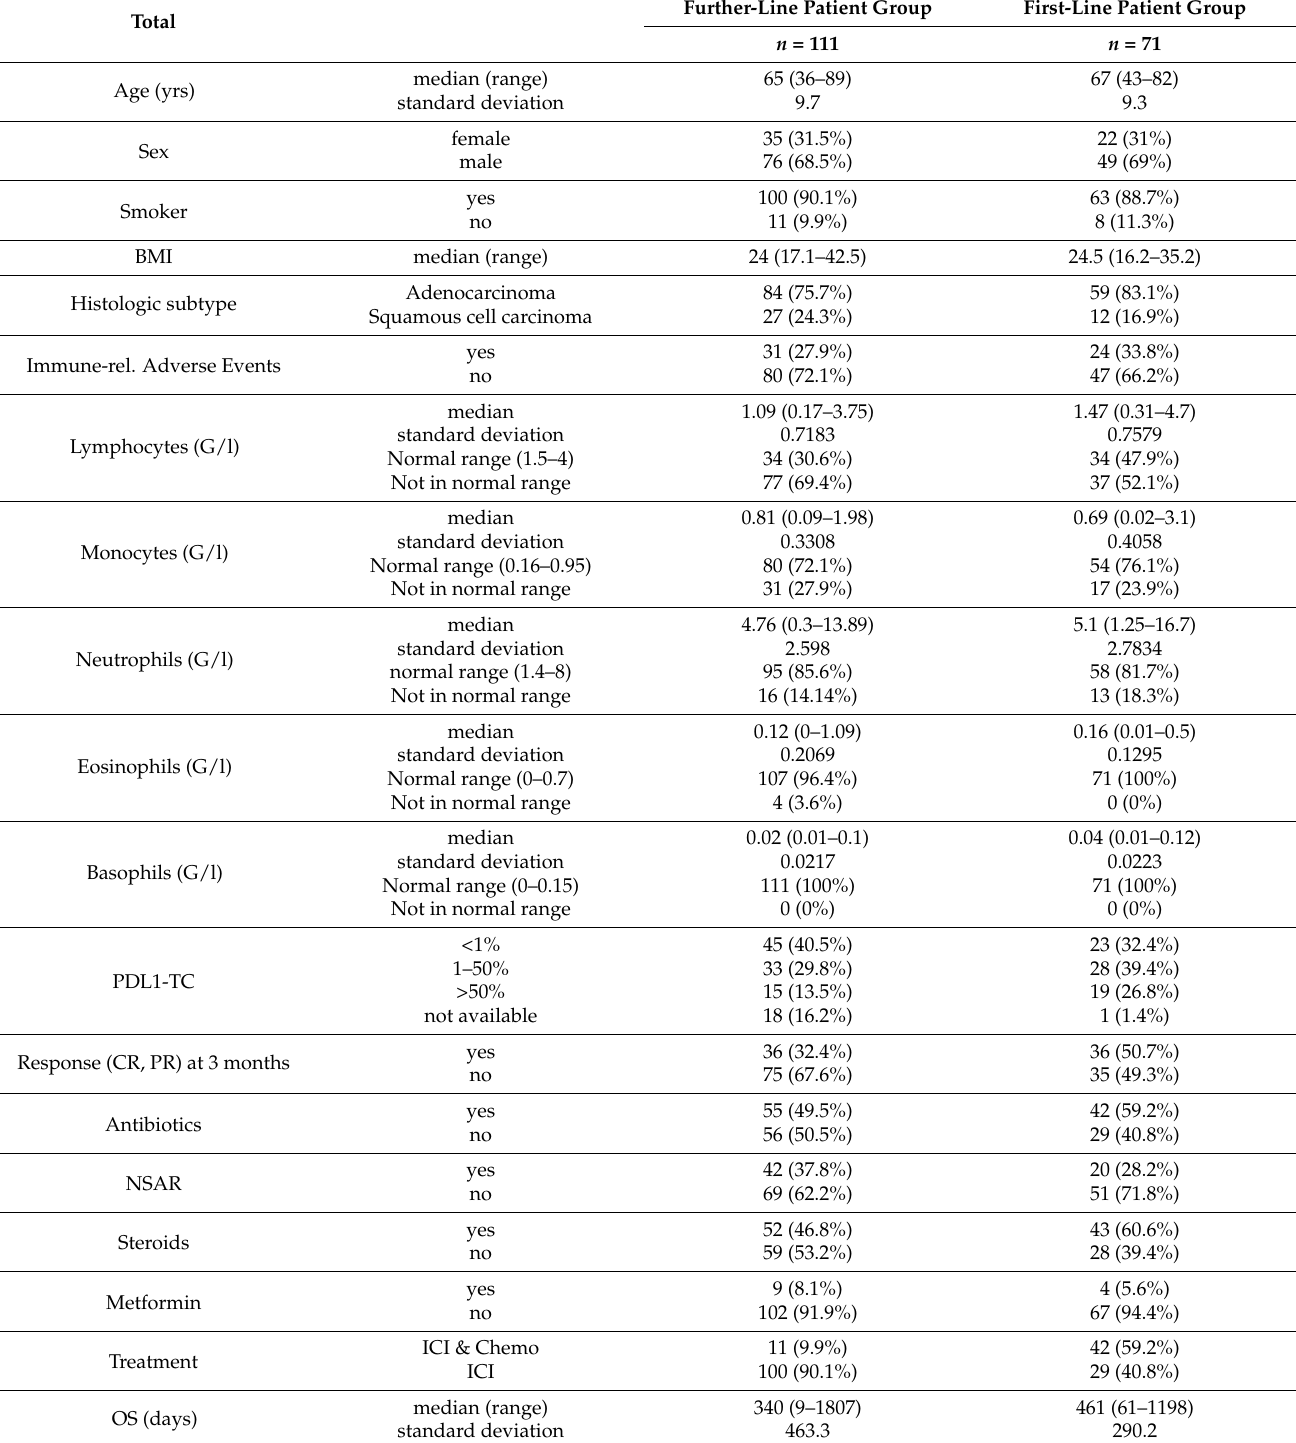
Table 1. Patient